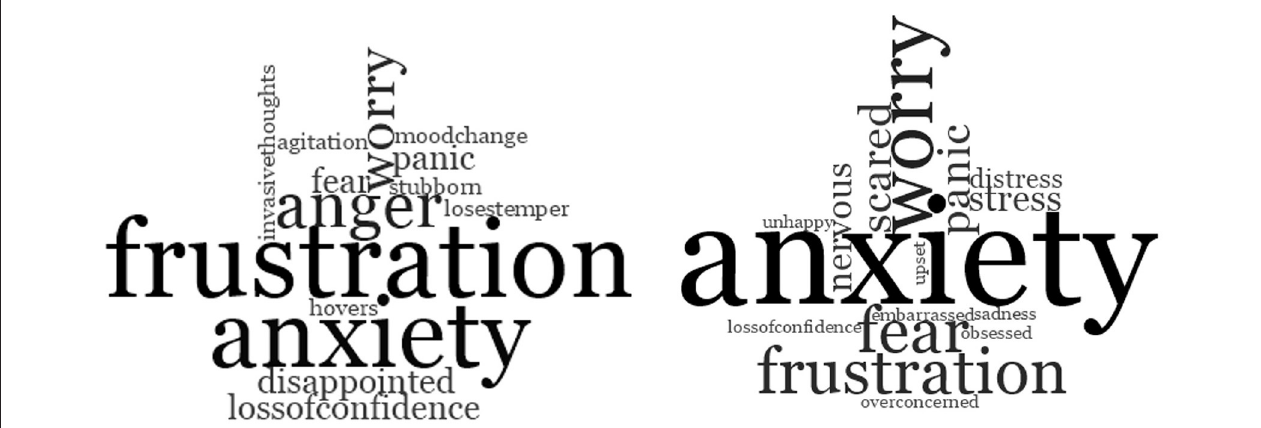
FIGURE 2 | Word clouds showing frequency of word use when participants were describing (left) . experiences focused on “agitation,” and (right) experiences focused on “anxiety”. may have downplayed depressive symptoms, but both carers and PLWD acknowledged sadness in response to the impact of dementia on their lives. Both PLWD and carers discussed was/wasn’t